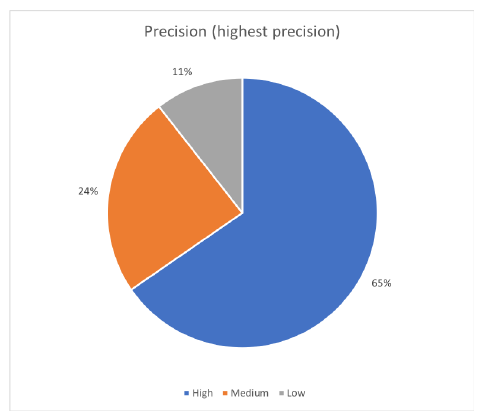
Figure 11. Level of precision achieved with highest precision